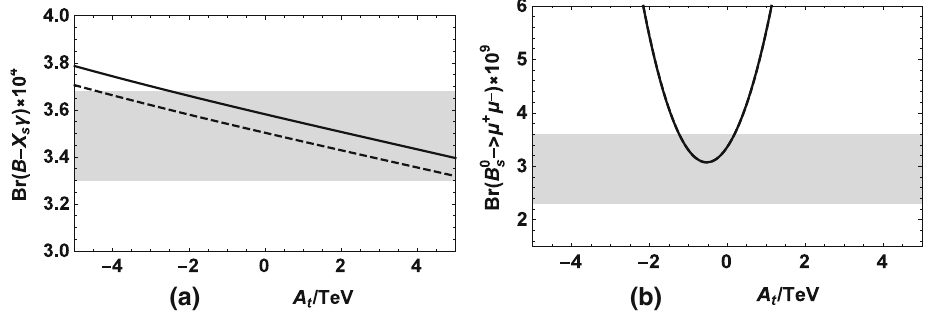
Fig. 6 Br ( ¯ B → X s γ) ( a ) and Br ( B 0 s → μ + μ − ) ( b ) versus A t for two loop result (solid line) and one loop result (dashed line). The gray area denotes the experimental 1 σ interval